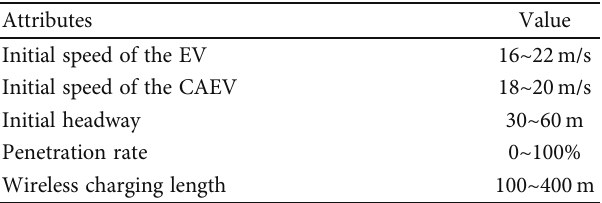
Table 6: Attribute settings in mixed tra ffi c.